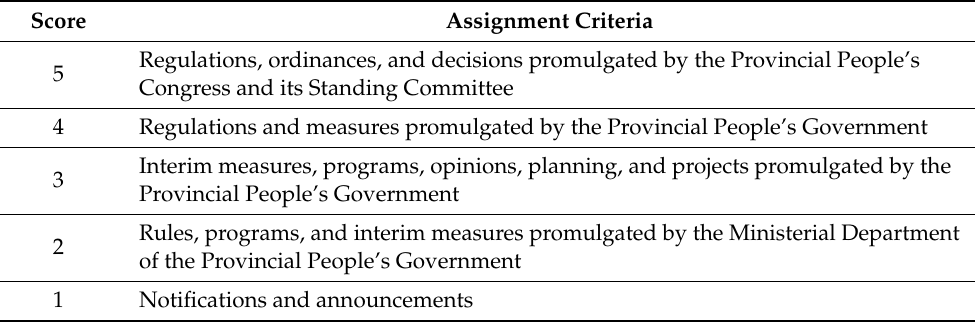
Table 1. Criteria of policy strengths.